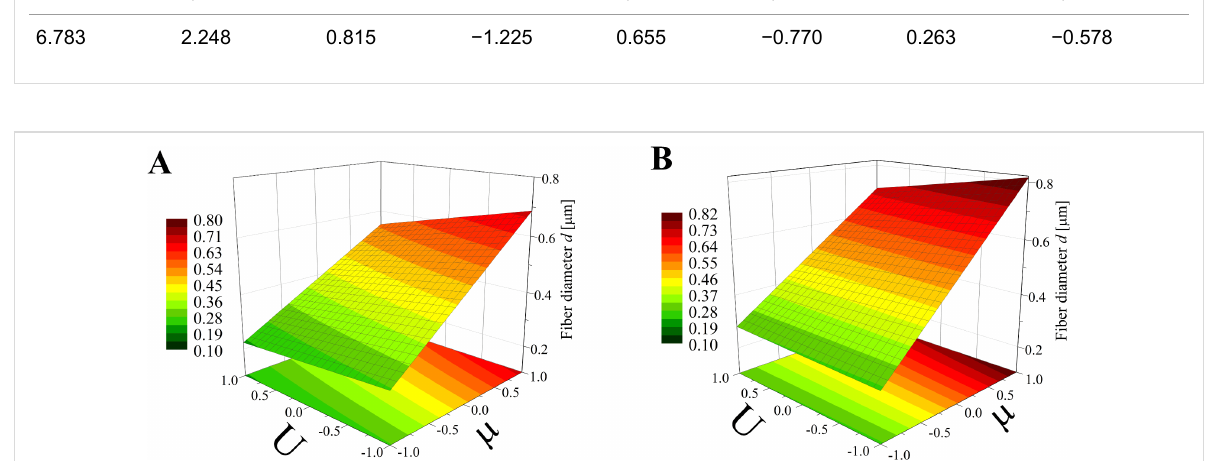
Table 10: The model coefficients determining the impact of solution dynamic viscosity (µ), solution flow rate ( Q ) and electrical voltage ( U ) on the aver- age bead size ( d b ). c 0